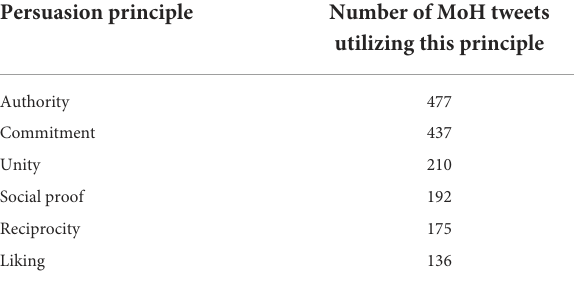
TABLE 4 Frequency of Cialdini’s Persuasion Principles in MoH tweets.